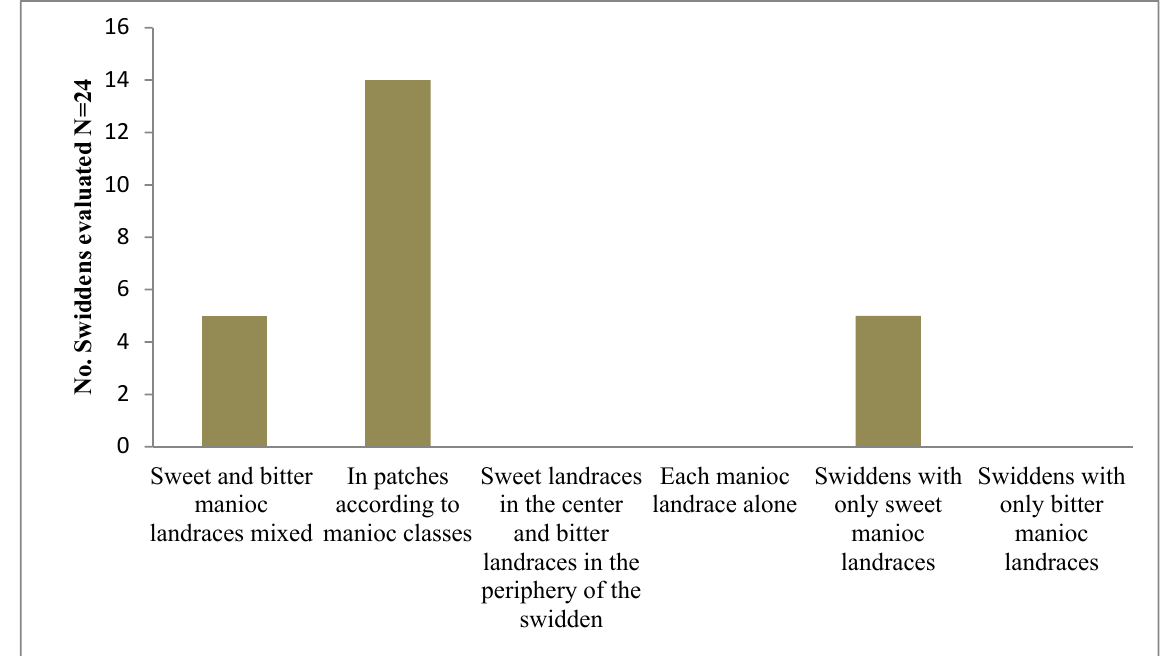
Figure 4. Manioc planting patterns in swiddens of indigenous